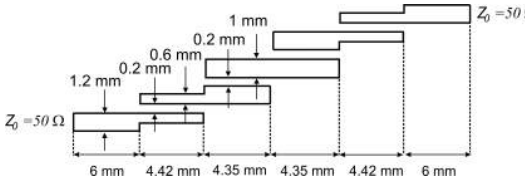
Figure 1: Configuration of the proposed C-band parallel coupled bandpass filter